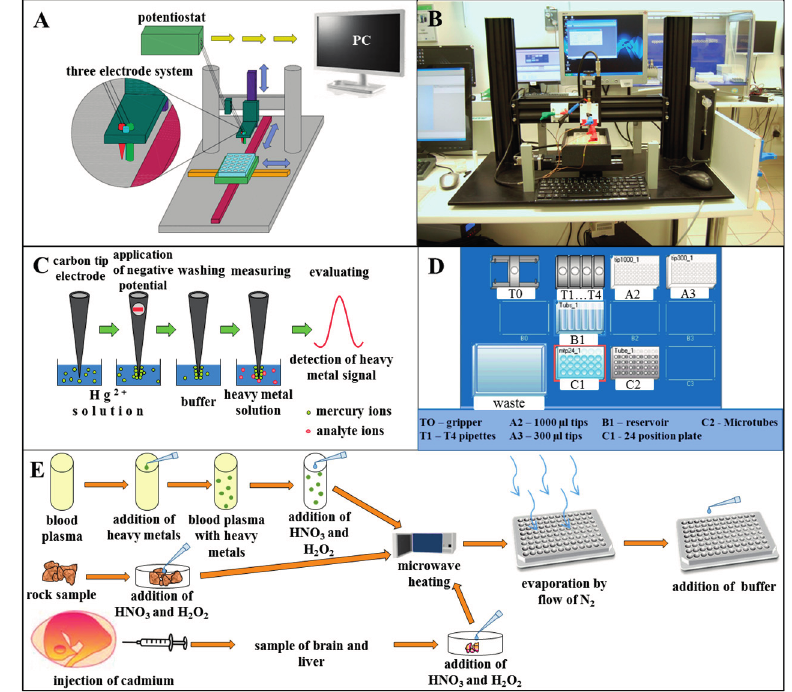
Figure 1. ( A ) Scheme and ( B ) photo of robotic device with electrochemical three-electrode detection system; ( C ) Individual steps of thin mercury film preparation on the surface of carbon tip electrode; ( D ) Scheme of automated pipetting system epMotion 5075 desktop, which was used to add buffer to mineralized samples of rocks; ( E ) The samples of